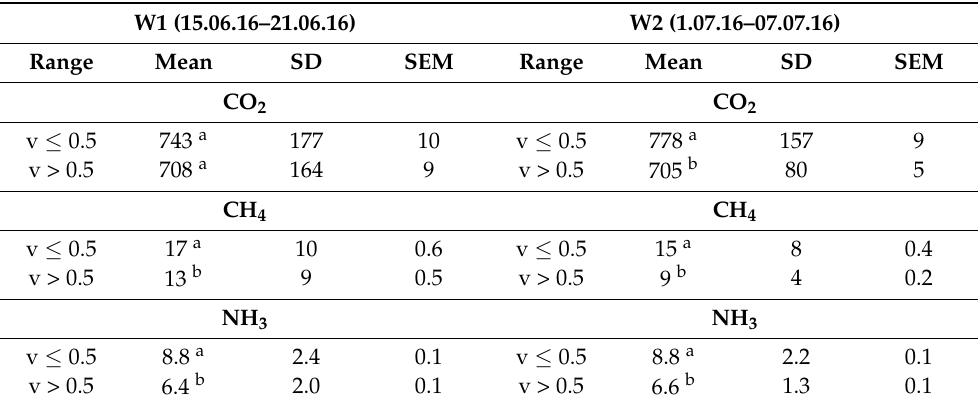
Table 3. Results of the statistical analyses for gas concentrations (ppm) of CO 2 , CH 4 and NH 3 , in the central SLs, at different airflow velocities v (ms − 1 ) during W1 and W2. Groups of values that do not share a letter (a, b) are significantly